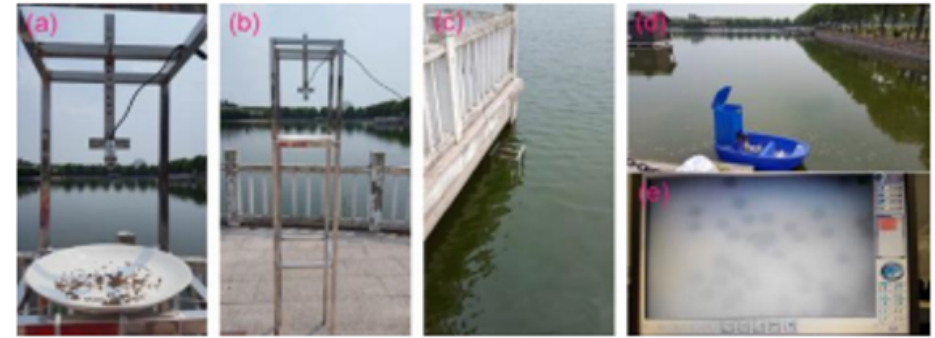
Figure 27. Flow chart of counting strategy.